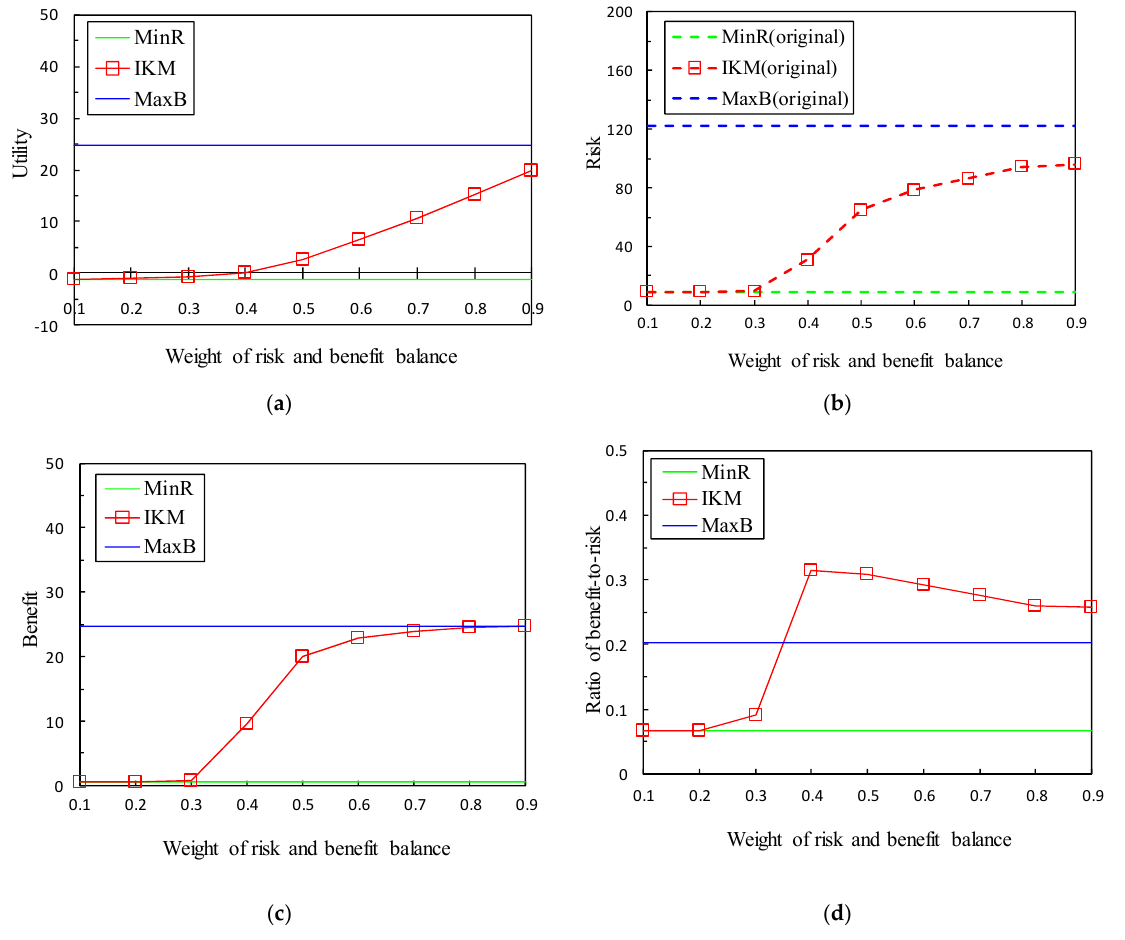
Figure 9. Effectiveness vs. weight of risk and benefit balance (Set #1.4). ( a ) Utility; ( b ) risk; ( c ) benefit; ( d ) benefit − to − risk ratio.